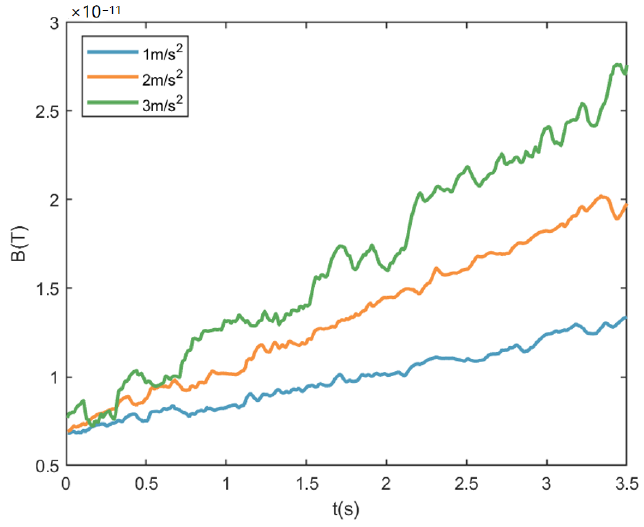
Figure 16. Magnetic field time-domain diagram of submarine movement with different accelerations at monitoring point A. Table 4. The growth rate of the wake magnetic field under different accelerations.